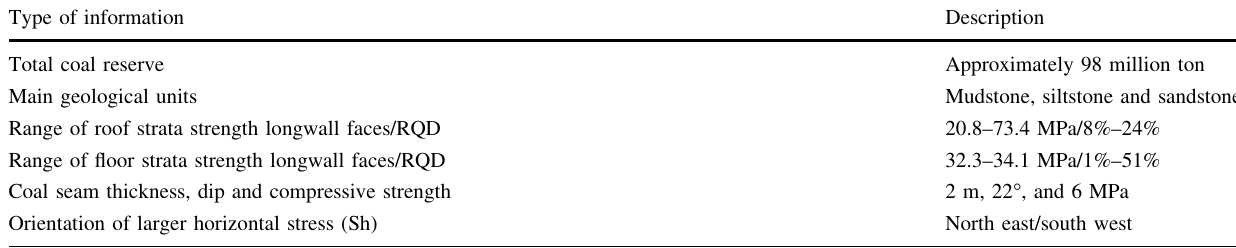
Table 1 Geological and geotechnical information about Parvadeh-I coal mine (IRASCO et al. 2005a, b) Type of